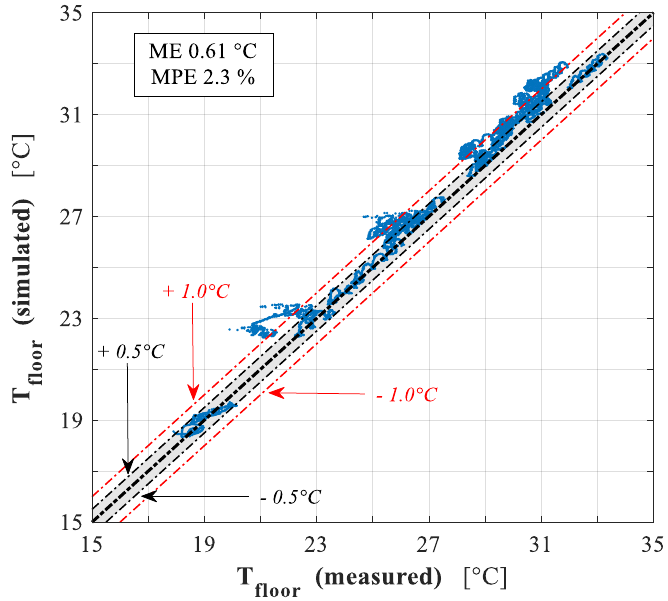
Figure 25. Floor temperature: simulated vs. experimental results (from February to November).